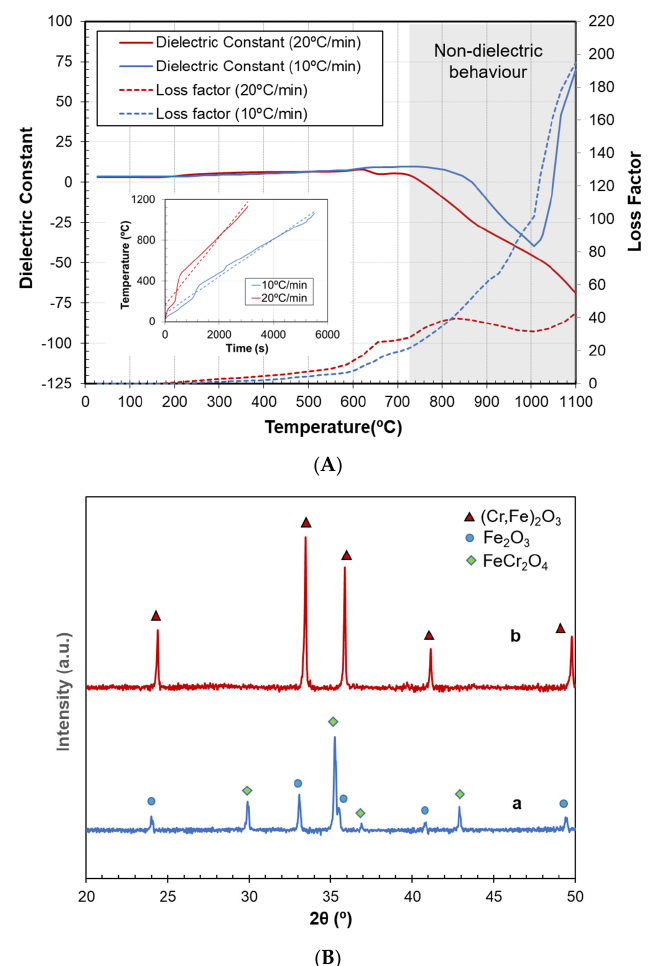
Figure 5. ( A ) Permi tt ivity measurements of the raw material mixture during the microwave synthesis of the pigment at two di ff erent heating rates (10 °C/min and 20 °C/min). Inset: heating rates applied during the process; ( B ) XRD pa tt erns of both processed pigments. a: Microwave-processed sample at 20 °C/min, b: microwave-processed sample at 10 °C/min.